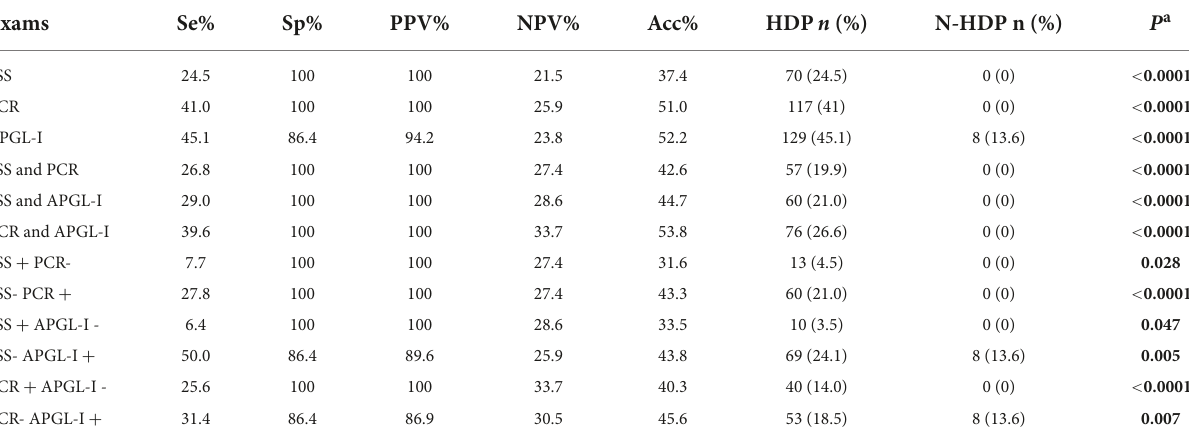
TABLE 2 Comparison of the performance for the SSS, PCR and APGL-I as diagnostic tests in HD.